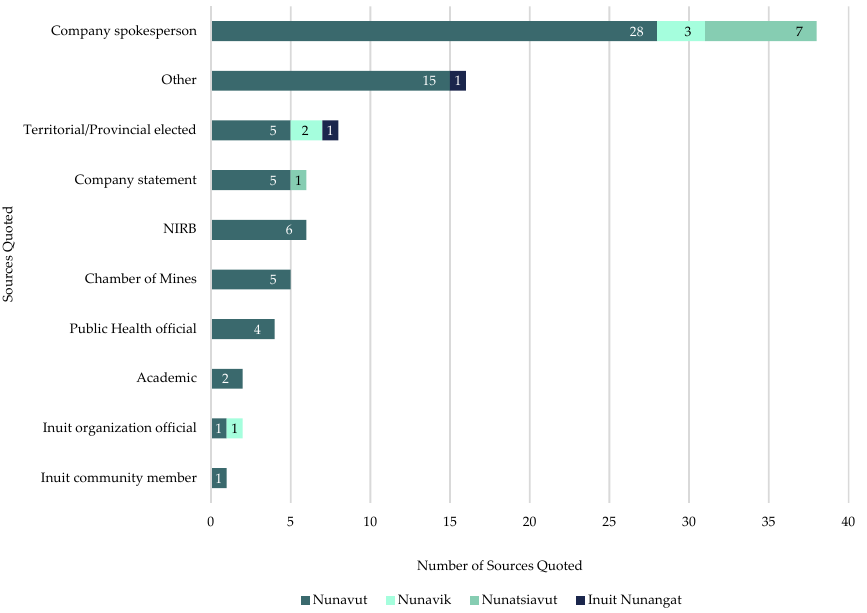
Figure 7. Number of sources quoted, by region, in included articles on mining industry’s initial response to COVID-19 in